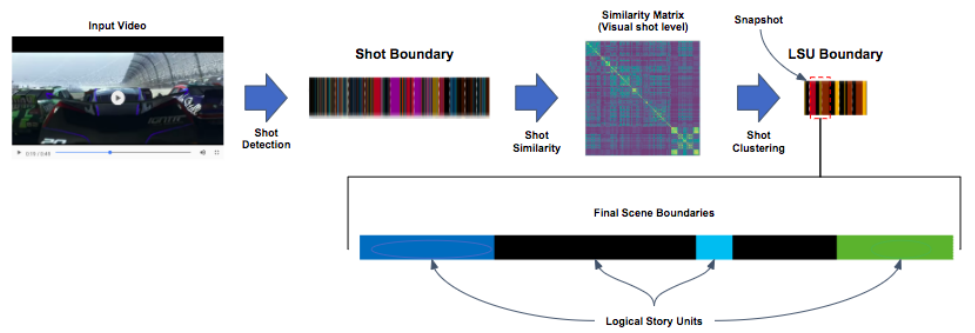
Figure 6. Overview of the LSU-detection module. Given the input video, the framework extracts audio–visual features to predict logical story unit boundaries based on semantic similarity between temporally coherent shots . The final decision boundary is based on thresholding the distance between consecutive shots .